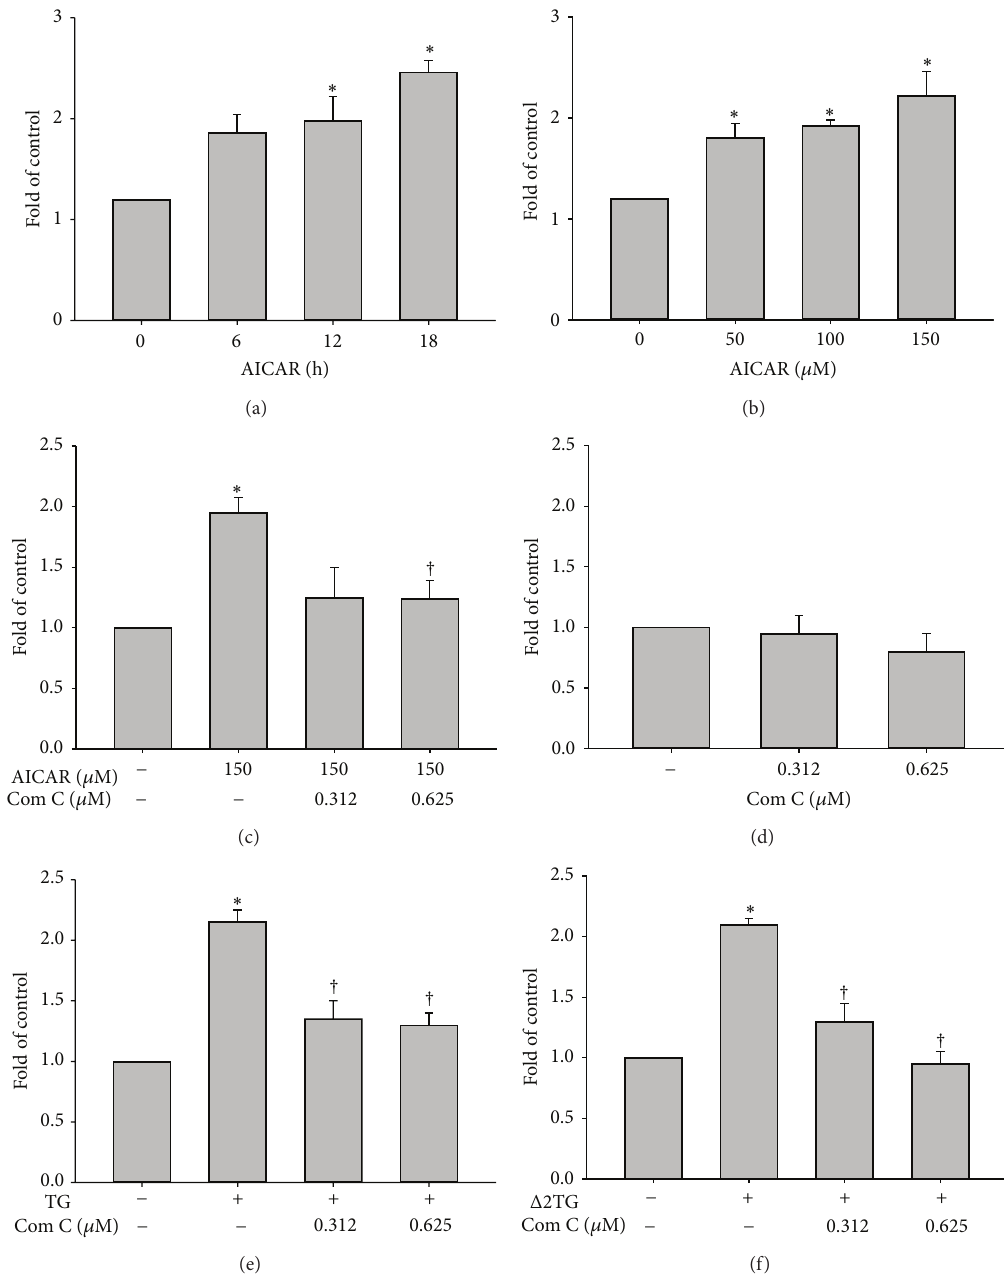
Figure 6: TG and Δ 2TG enhanced adiponectin mRNA expression was mediated through the AMPK pathway in THP-1 cells. The expression of adiponectin mRNA was examined by quantitative RT-PCR. Macrophages were treated with 150 𝜇 M of AICAR (an AMPK activator) for the indicated time (a) or with the indicated concentration for 18h (b). Macrophages were treated with compound C (an AMPK inhibitor) for the indicated concentration and then with (c) or without (d) AICAR for 18h and then adiponectin mRNA expression was measured by real-time PCR. Macrophages were incubated for 1h with compound C and then for 18h with or without 9 𝜇 M TG (e) or Δ 2TG (f) in the continued presence of the inhibitor, and then, adiponectin mRNA expression was measured by real-time PCR. ∗ 𝑃 < 0.05 as compared to the untreated cells. † 𝑃 < 0.05 as compared to the TG or Δ 2TG-treated